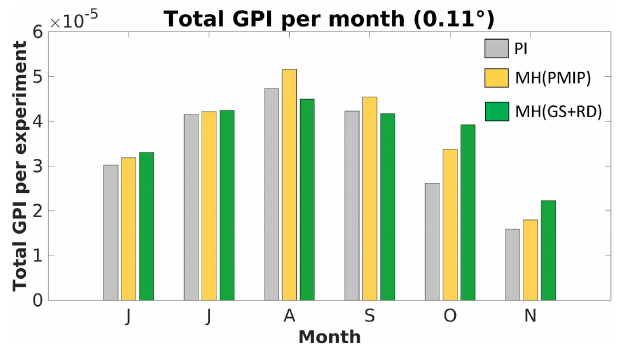
Figure 10. Seasonal variation (JJASON) of the GPI summed over the experimental domain for the three